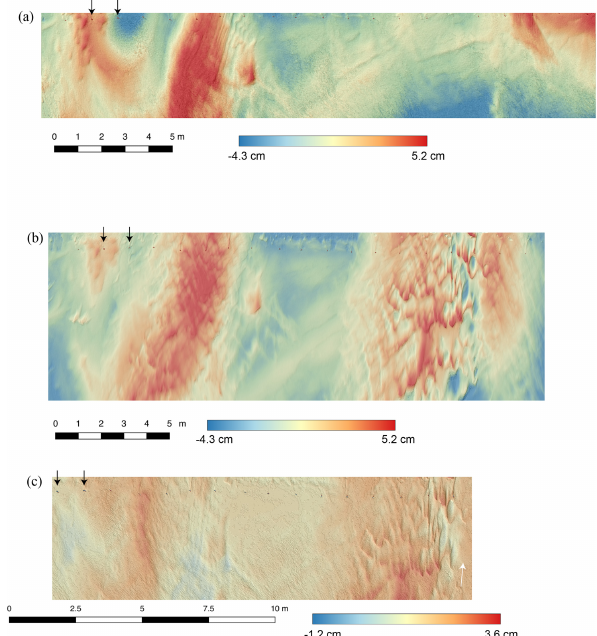
Figure 4. Relative snow surface height in the region monitored for accumulation. Panel (a) shows the surface height on 19 July be- fore a storm system swept through the EastGRIP camp on 20 July, and panel (b) shows the surface height on 22 July after the storm. Black arrows in upper left corner of each panel indicate the first two poles in the row of accumulation monitoring sites. (c) Snow height difference between digital elevation models from 19 and 22 July measured from the top of the poles inferred to be accumulation dur- ing the storm. The white arrow indicates prevailing wind direction during the storm.